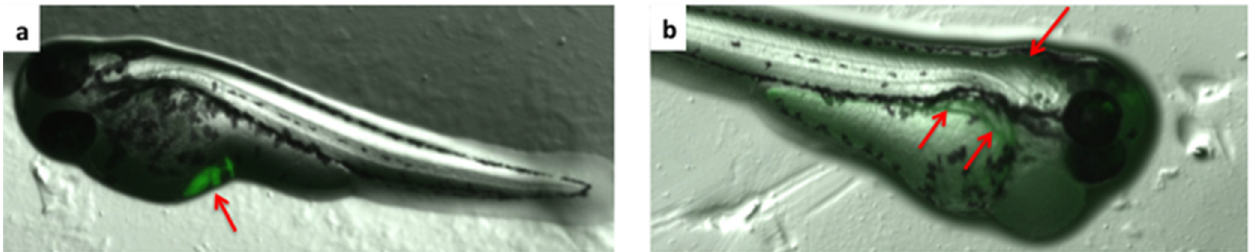
Fig 2. Fluorescent S . suis in injected zebrafish larvae. Zebrafish larvae were injected with 1000 colony forming units in the yolk sac and in the Duct of Couvier (DoC) and observed under a Leica M205 FA fluorescent stereo-microscope. a) Localization of fluorescent S . suis S10 injected in the yolk sac, 1 hpi, b) Localization of fluorescent S . suis S10 injected in the DoC, 1 hpi.